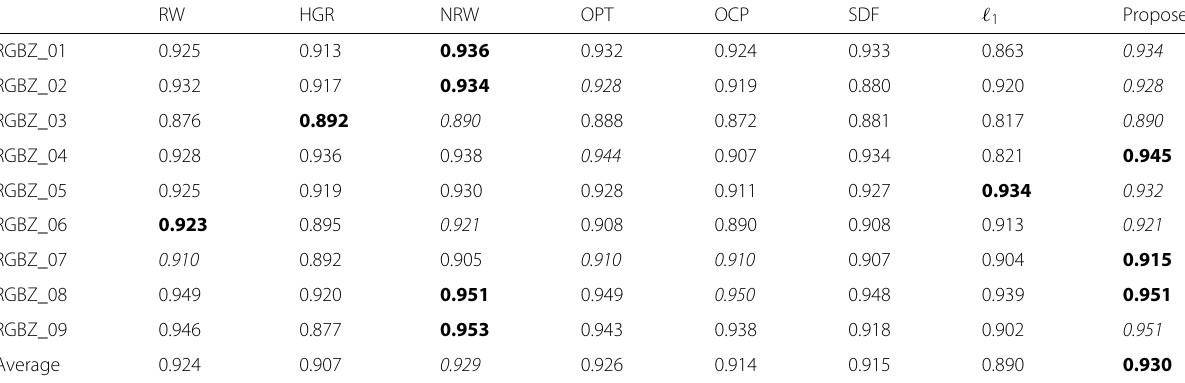
Table 3 SSIM of estimated depth on RGBZ datasets when cross-boundary scribbles are absent RW HGR NRW OPT OCP SDF (cid:2) 1 Proposed